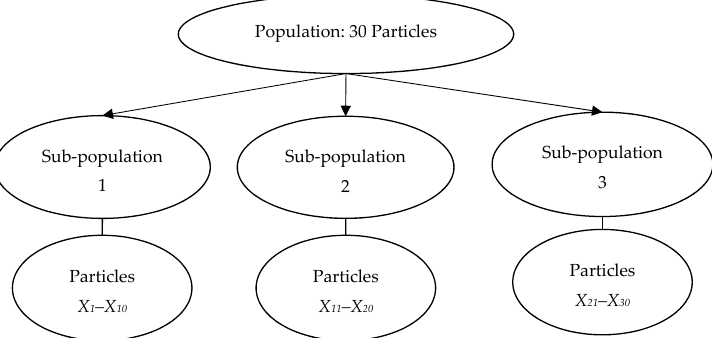
Figure 1. The example of structure of co ‐ evolution binary particle swarm optimization with multiple inertia weight strategy (CBPSO ‐ MIWS).